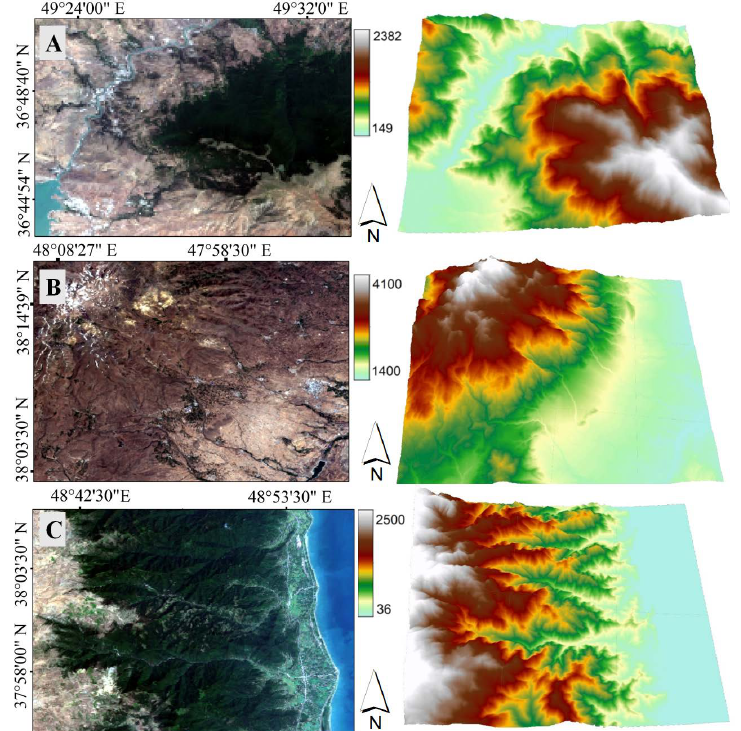
Figure 1. Experiment sites: ( A ) Site-1, ( B ) Site-2, and ( C ) Site-3. Left and right columns show the true color composites of Landsat-8 (R: Band-4, G: Band-3, B: Band-2) and the SRTM elevation maps,